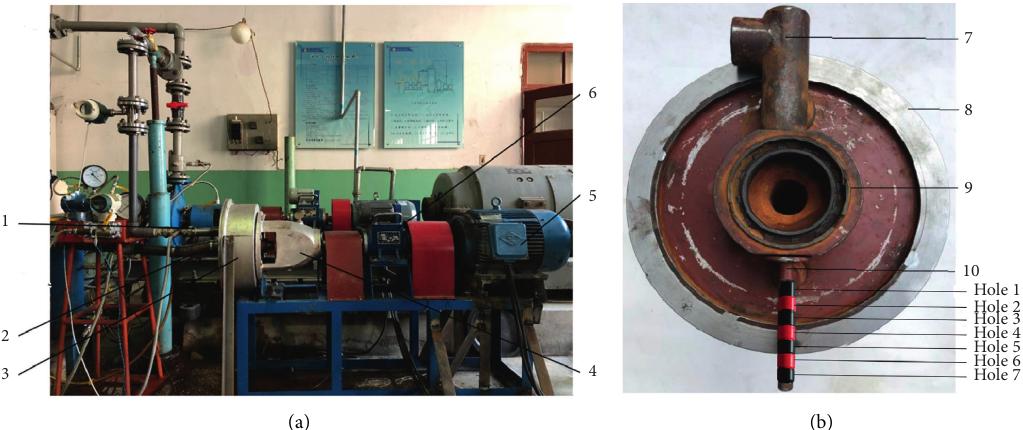
Figure 3: Test system. (a) Performance test bench for Roto-Jet pump. (b) Collecting pipe and piezometer tube. 1: collecting pipe outlet; 2: impeller inlet; 3: Roto-Jet pump; 4: suspension; 5: motor; 6: torquemeter; 7: collecting pipe; 8: fixed plate; 9: framework oil seal; 10: piezometer tube. Table 2: Configuration scheme of model structure. Test